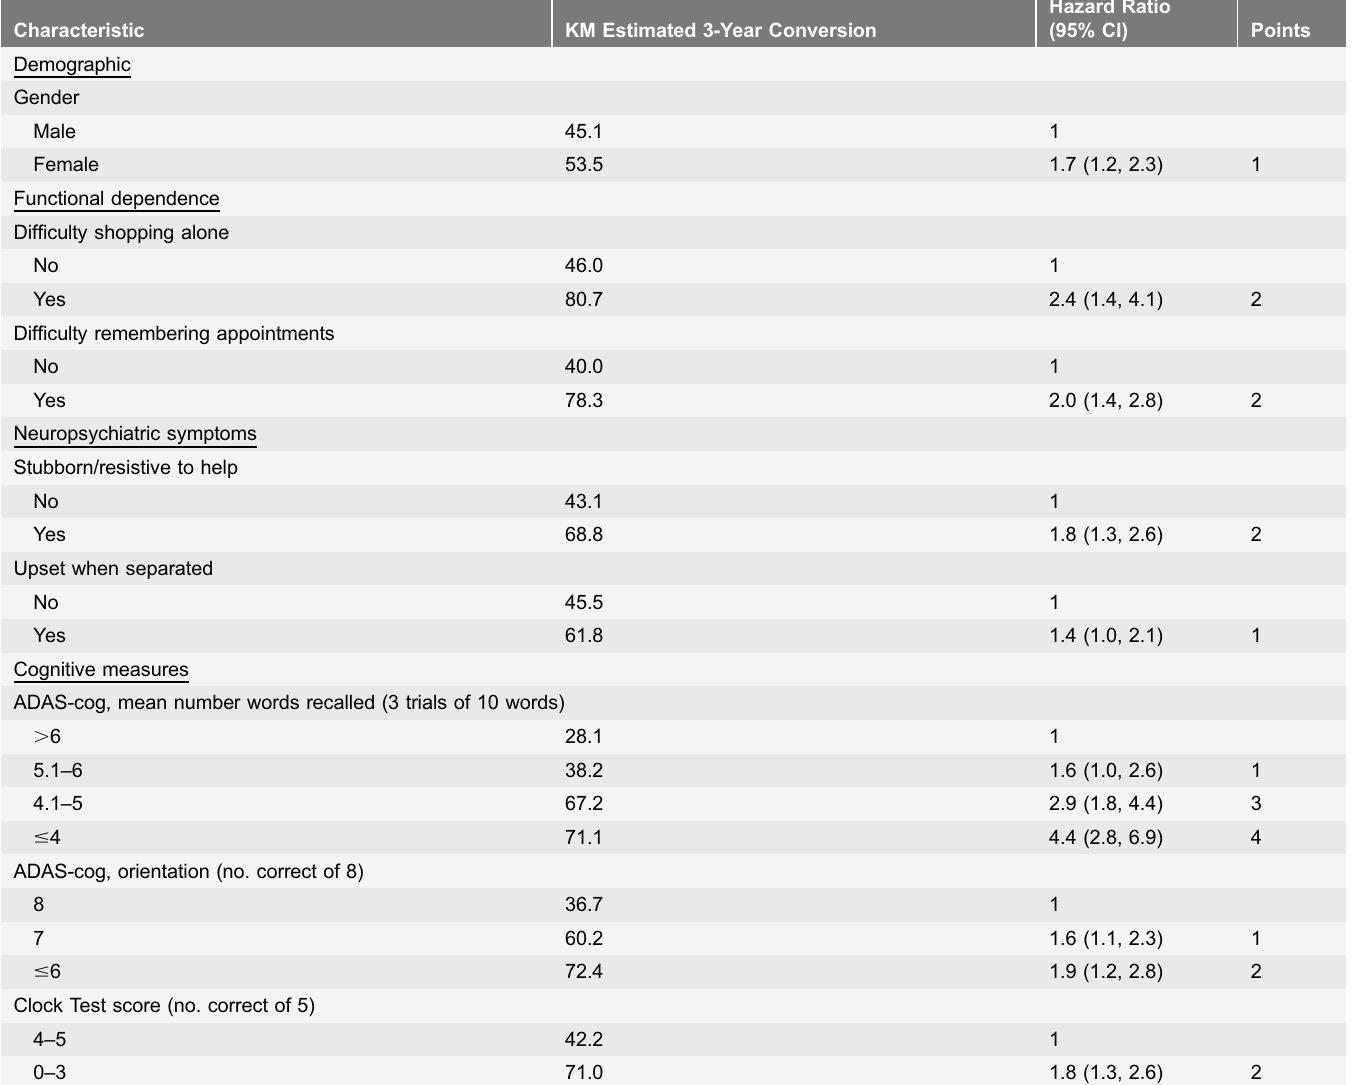
Table 2. Factors Associated with Conversion from Amnestic MCI to